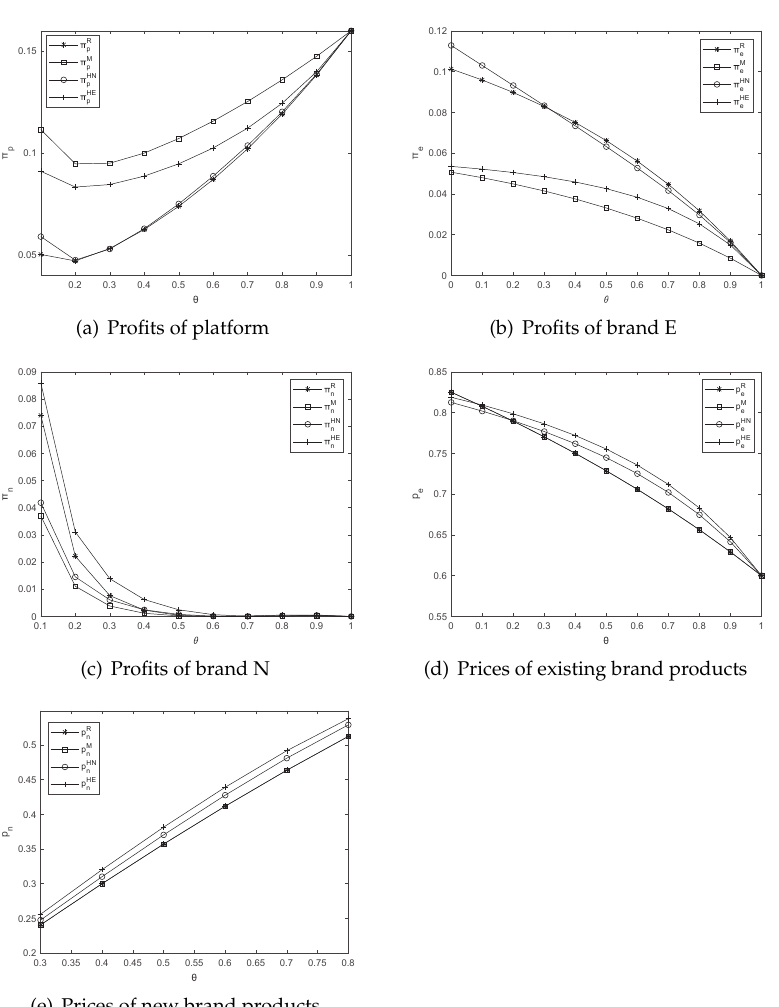
Figure 6. The impacts of parameter θ on the equilibrium